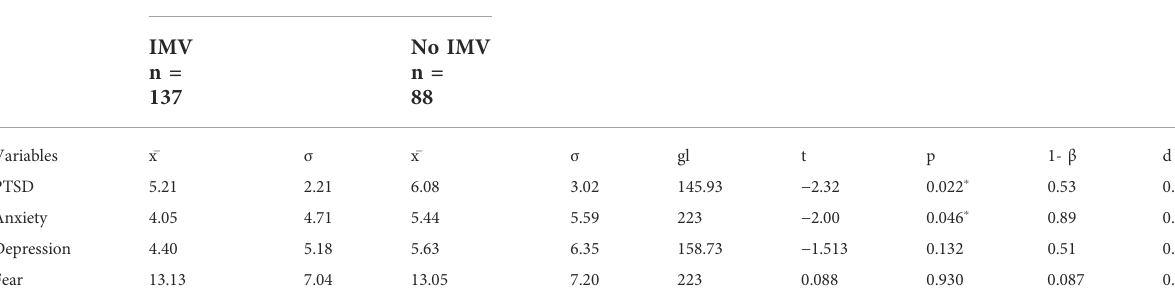
TABLE 6 Differences between the type of treatment required in hospitalization in PTSD, anxiety, depression, and fear scores.